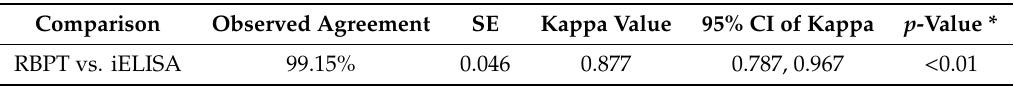
Table 5. Comparison of results of RBPT and iELISA tests used to detect anti- Brucella antibodies in cattle and bu ff aloes. iELISA RBPT Total Negative Positive Count 795 6 801 Negative Expected Count 770 31 801 Count 1 26 27 Positive Expected Count 26 1 27 Count 796 32 828 Total Expected Count 796 32 828 Table 6. Agreement between RBPT and iELISA tests used for sero-diagnosis of brucellosis in cattle and bu ff aloes ( n = 828). Comparison Observed Agreement SE Kappa Value 95% CI of Kappa p -Value * RBPT vs. iELISA 99.15% 0.046